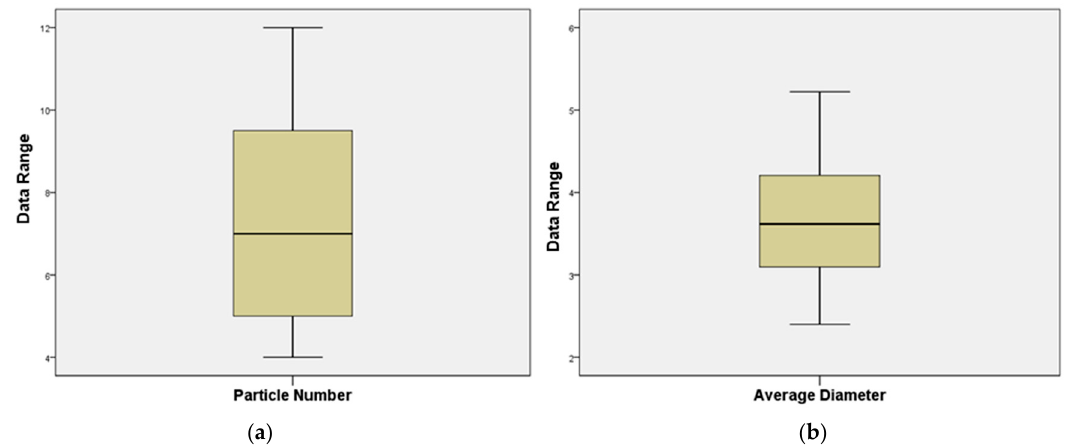
Figure 9. Results of outlier test: ( a ) particle number and ( b ) average diameter.